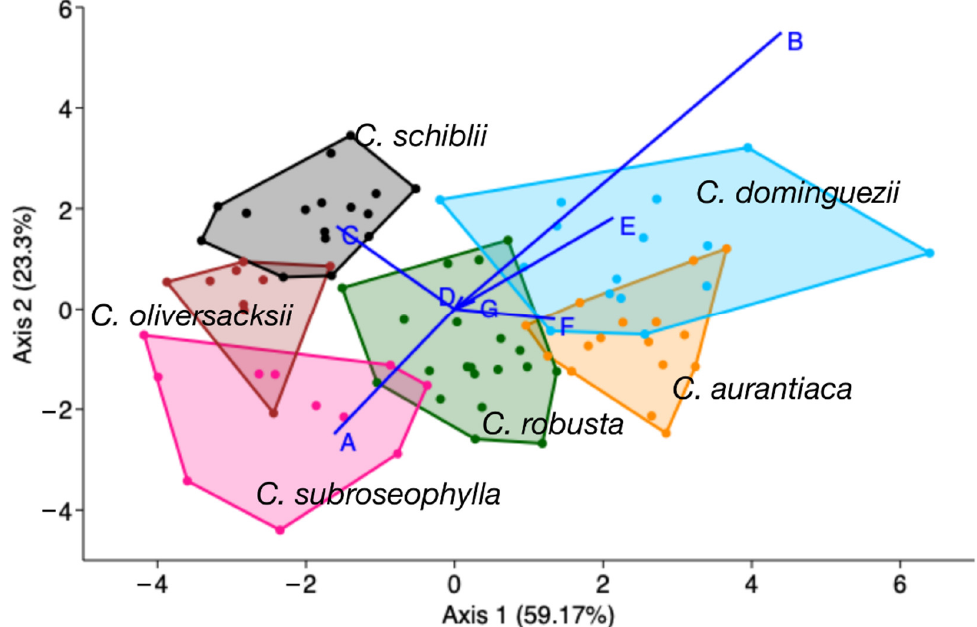
Figure 3. Linear discriminant analysis plot showing the dispersion of the samples of six compared species along the two main axes. Biplots A–F indicate the direction and relative loading score of each trait variation along the two axes. Traits A–G correspond to those listed in Table 3: A, length of petiole; B, length of rachis; C, number of leaflet pairs; D, length of median leaflets; E, distance between median leaflets; F, width of median leaflets; G, width of basal leaflets. Table 5. Confusion matrix obtained from the Linear Discriminant Analysis (LDA). Rows indicate given groups, and columns indicate groups predicted by the LDA. Bold values indicate correctly assigned individuals to their own species, supporting their taxonomic identity. Abbreviations: aur = C. aurantiaca ; rob = C. robusta ; sub = C. subroseophylla ; dom = C. dominguezii ; oli = C. oliversacksii ; sch = C. schiblii .